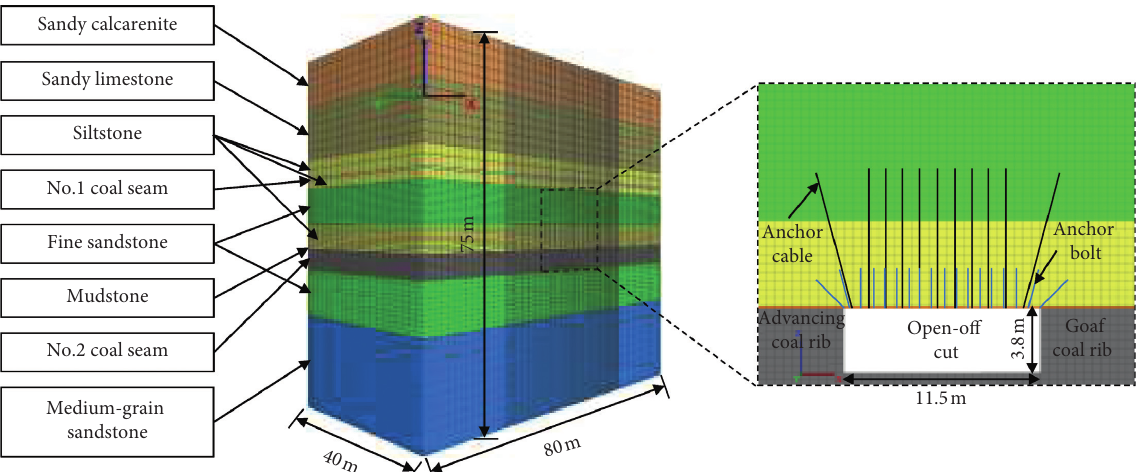
Figure 3: Configuration of the model performed using FLAC3D and support pattern of roof anchor bolts and anchor